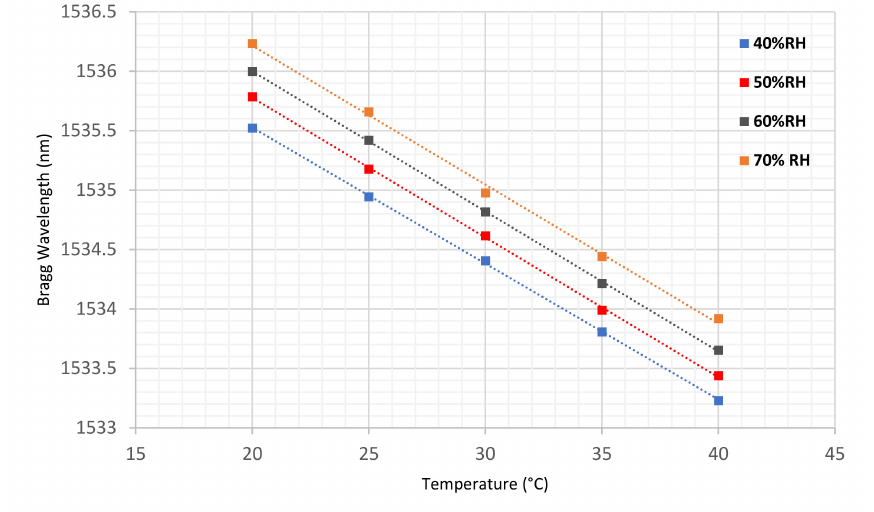
Figure 5. Comparison of the polymer sensor’s response to temperature changes at different levels of relative